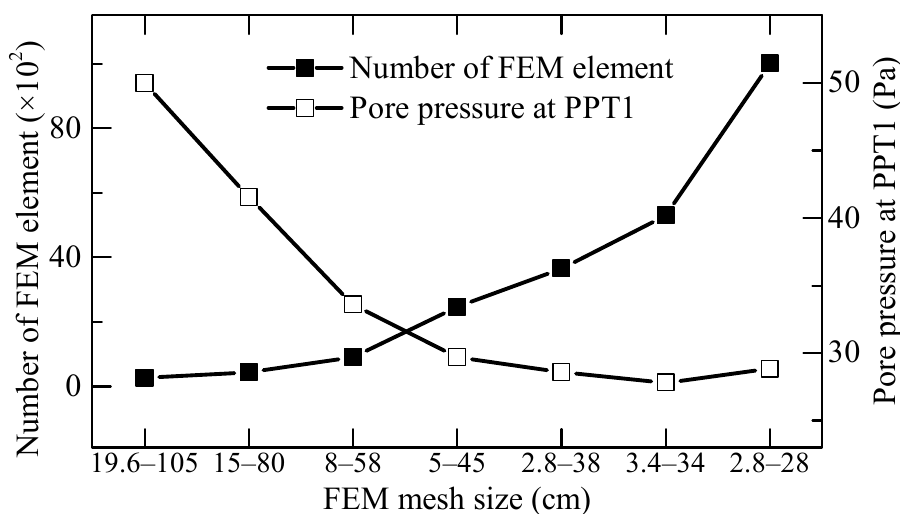
Figure 3. FEM mesh convergence test.